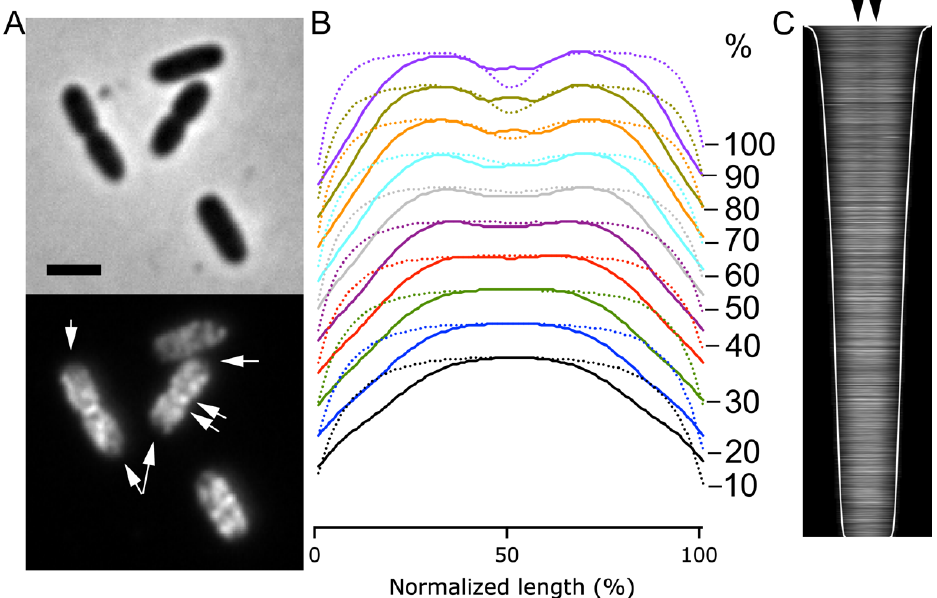
Figure 5. E. coli wild type cells immunolabelled against OmpA. LMC500 wild type cells were grown to steady state in minimal medium at 28 ° C. ( A ) Phase contrast image on top, and the corresponding fluorescence image at the bottom, with arrows indicating the empty old poles and the empty new poles adjacent to the leading edge of the constriction. Scale bar is equal to 2 μ m. ( B ) Fluorescence average profiles in age bins of 10%, as indicated. The dotted line presents the diameter of the cells, and the solid line, the OmpA fluorescence. ( C ) Demograph of the fluorescence of OmpA of all cells sorted according to their cell length, and with the edge of the cells indicated by the white line. The black arrows indicate the part of newly synthesized cell poles that do not have OmpA (n = 3223).